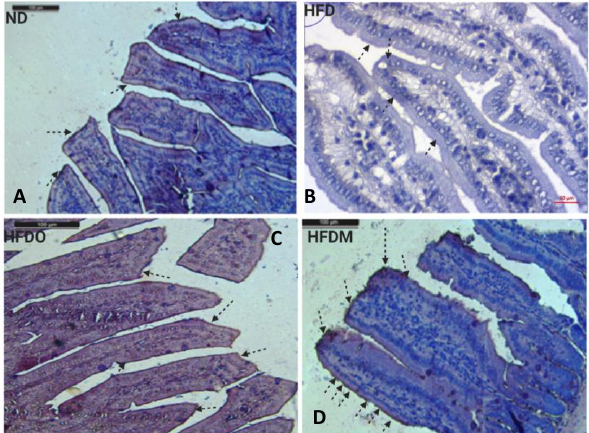
Figure 16. The effects of MESK supplementation on Claudin-1 expression in mouse jejunum (Magnification 20x). ( A ) Normal diet, ( B ) high-fat diet, ( C ) HFDO: HFD + Orlistat, and ( D ) HFDM: HFD + MESK. HFD-fed mice displayed reduced expression of Claudin-1 in both villus tip and villus border (arrows). Treatment with MESK and Orlistat restored the expression of Claudin-1 on both the villus tip and villus border (arrows). Scale bar indicates 10 um.